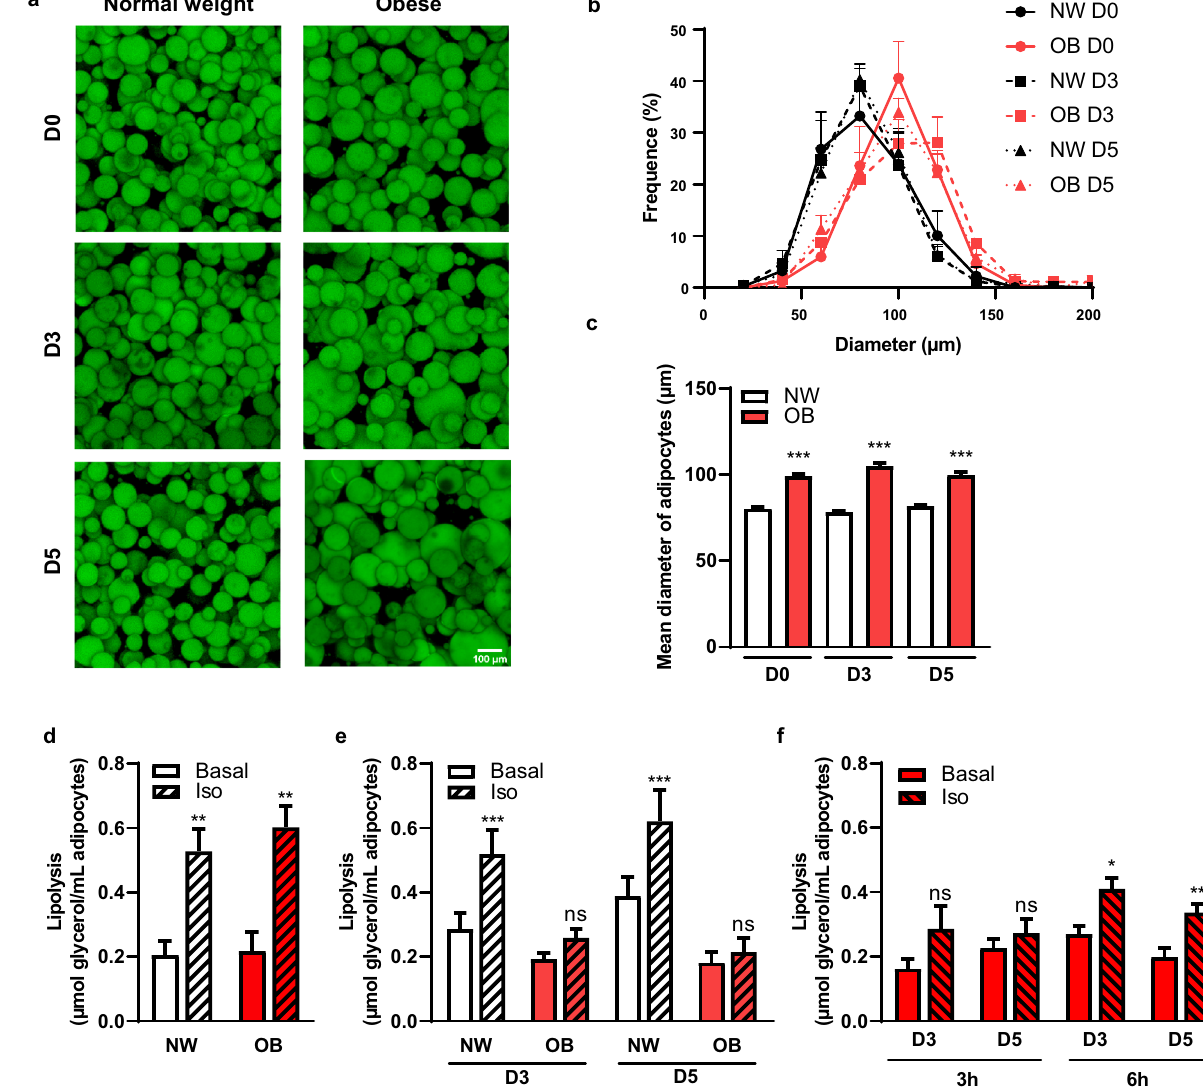
Figure 4. Our 3D matrix model maintains intact and functional adipocytes in both lean and obese conditions. ( a ) Maximum intensity projection of Z-stack acquired through confocal microscopy. Representative images of M-Ads obtained from normal weight or obese patients, after BODIPY® 493/503 staining, cultured in fibrin matrix for the indicated time; Scale bar, 100 µm. ( b ) Distribution of adipocyte diameter (µm) according to their culture condition over time in relative frequency in samples obtained from normal weight (NW) (n = 6) or obese (OB) patients (n = 3). ( c ) Mean diameter of adipocytes (µm) obtained from NW (n = 6) or OB patients (n = 3) at different time point. ( d ) Amount of glycerol released after 3 h in the presence or not (basal lipolysis) of isoprenaline (iso) in adipocytes embedded in gels for NW (n = 9) or OB (n = 6) patients. ( e ) Similar experiments were performed with adipocytes cultured in 3D matrix for the indicated time isolated from NW (n = 16) or OB (n = 10) patients. ( f ) Amount of glycerol released after 3 or 6 h in the presence or not (basal) of isoprenaline (iso) in adipocytes isolated from obese patients (n = 3). Histograms represent mean ± SEM, ns non- significant, *P < 0.05, **P < 0.01, ***P <